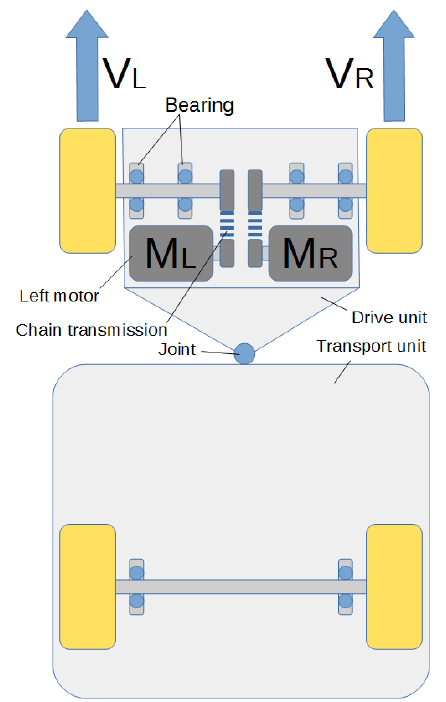
Figure 6. A scheme of the chassis of the robot for inspection in underground mine.